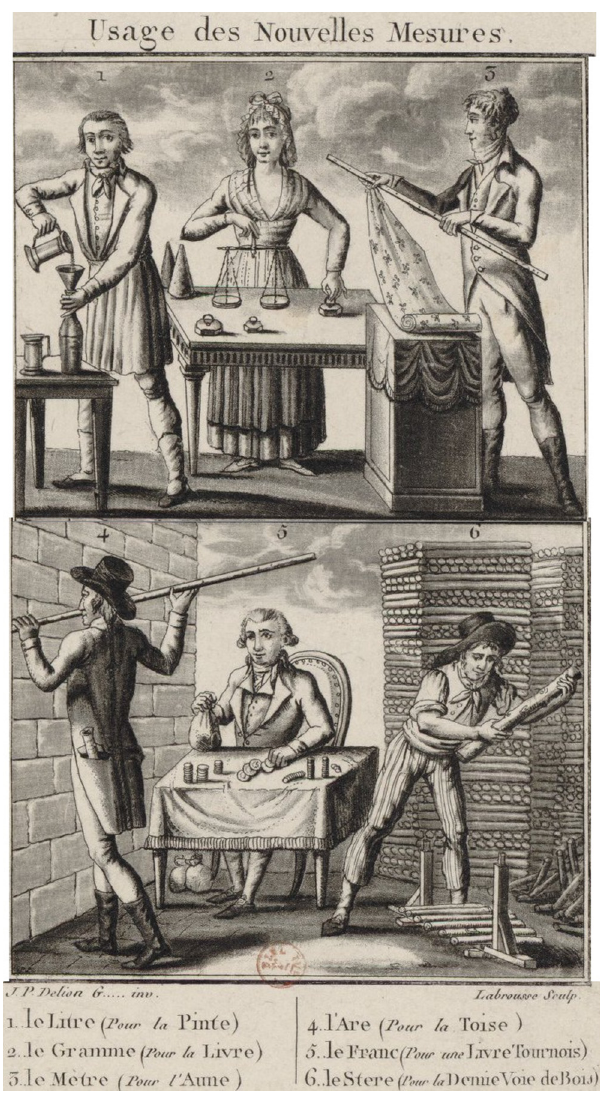
Fig. 2. New decimal